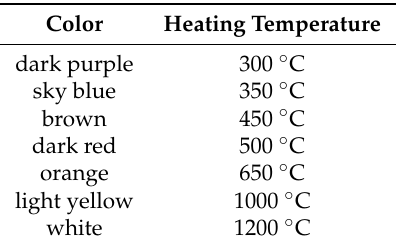
Table 1. Relationship between color change of ferrous metal and heating temperature. The heating duration time is set with 30